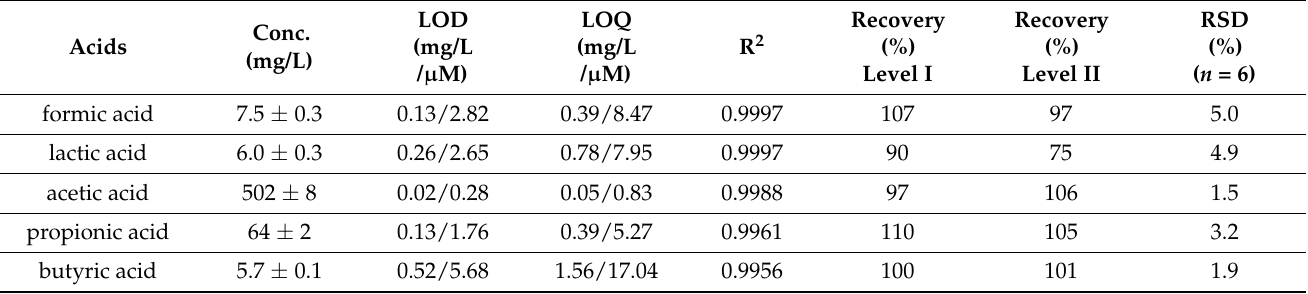
Table 1. Validation parameters for organic acids in saliva samples obtained using the isotachophore- sis